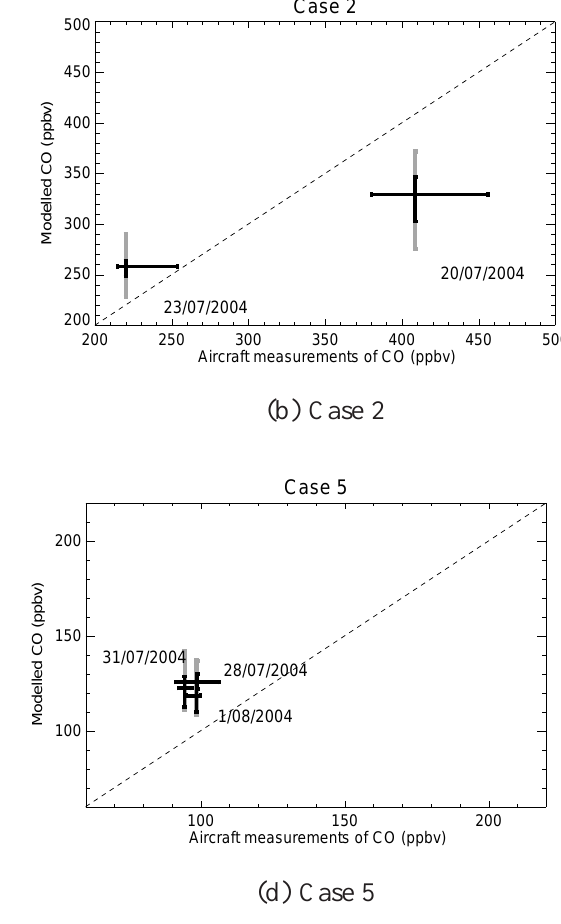
Fig. 8. Comparison of modelled and observed CO, as Fig. Fig. 8. ComparisonofmodelledandobservedCO,asFig.6.